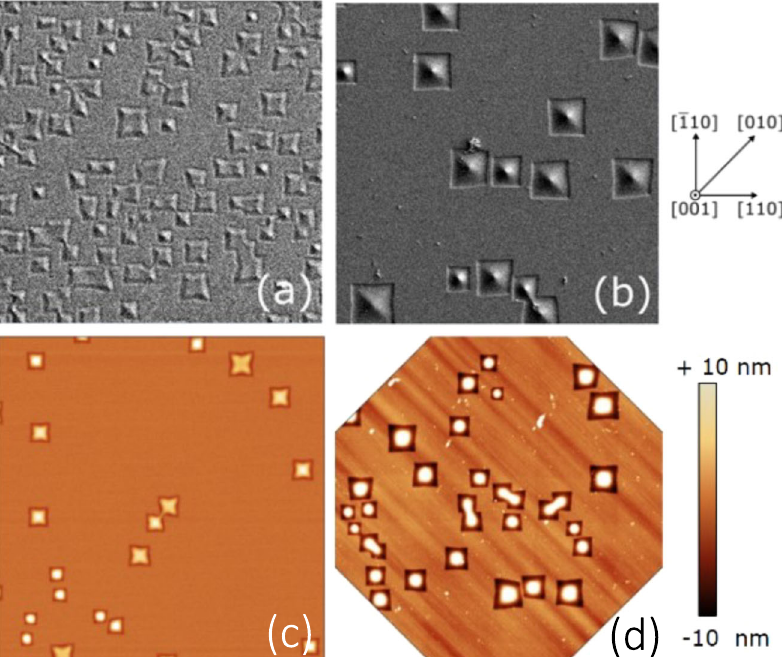
Fig. 1 Experimental measurements of close-to-nucleation states generated by laser annealing at a critical energy density. a Scanning electron microscopy 5 × 5 μ m 2 images of bulk Si(001) after LA at 1.88 J cm − 2 laser fl uence and ( b ) 1300-nm-thick Ge epilayer on Si after LA at 0.83 J cm − 2 , both within the surface melt regime. Atomic force microscopy 5 × 5 μ m 2 images (different areas) of the same Si and Ge samples are reported in ( c , d ), respectively. The laser wavelength is 308 nm and the pulse duration is ~146 ns. For these precise conditions the maximum temperature exceeds the materials' melting points at the surface proximity and for a few nanoseconds lasting transient. As a consequence visual snapshots of the solid/liquid nucleation stage are obtained. We note that square-shaped hillocks with 〈 110 〉 -aligned sides, formed during LA, are clearly